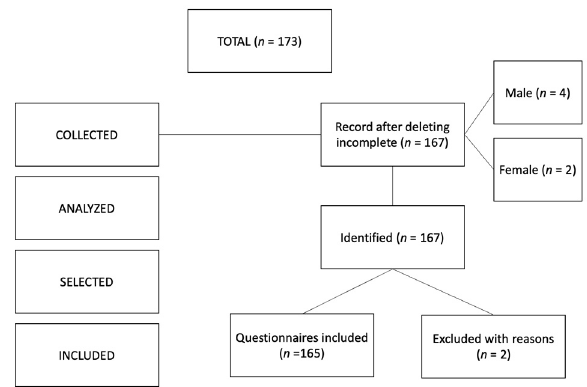
Figure 1. Flowchart of the sample selection procedure.